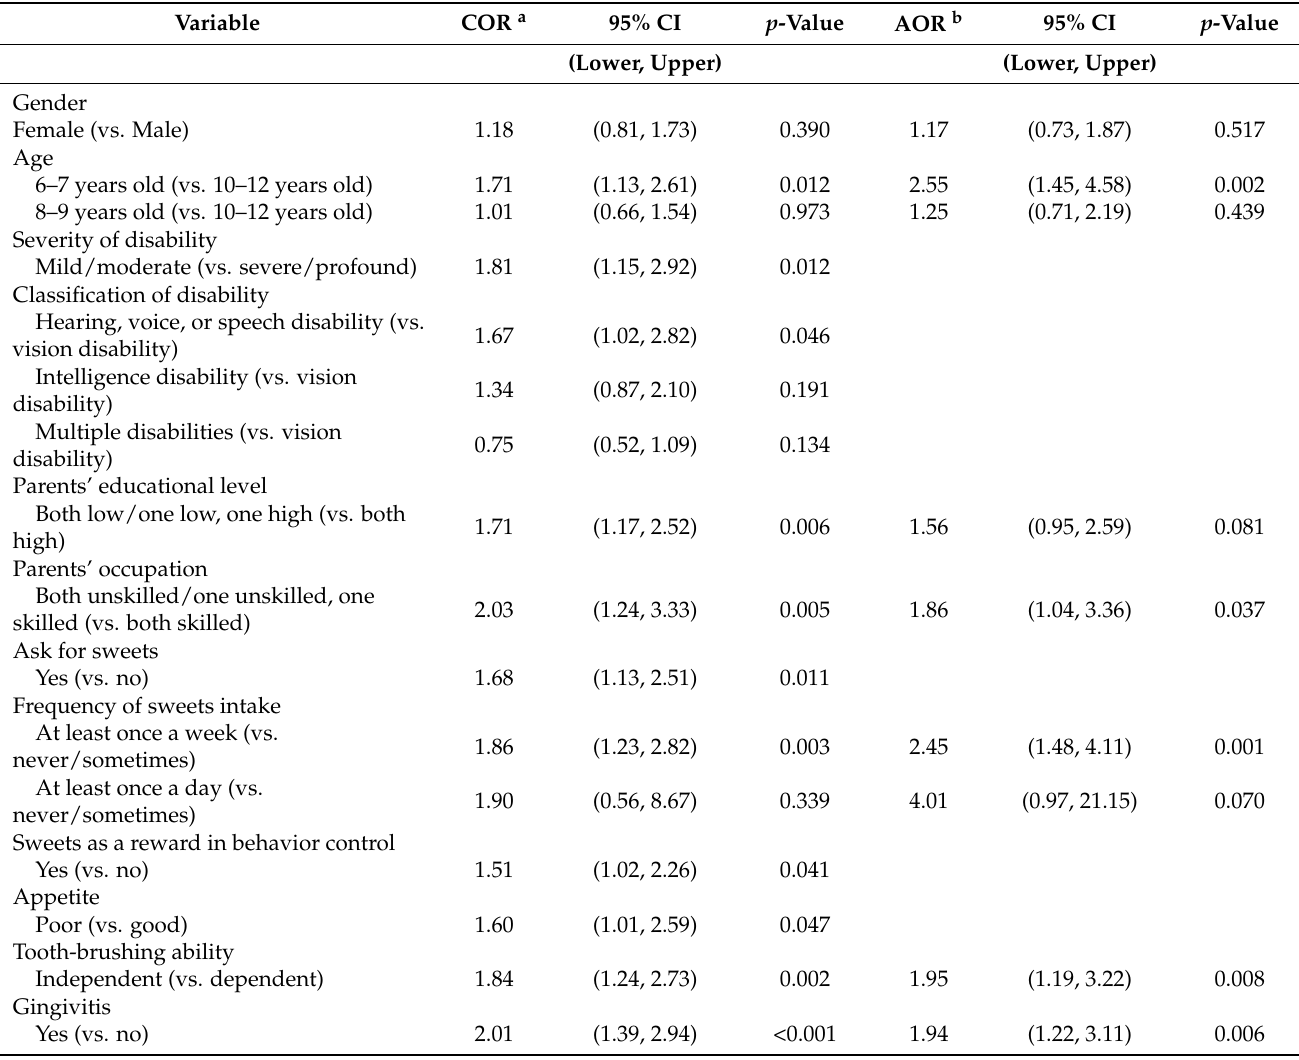
Table 4. Logistic regression models of risk factors associated with restorative treatment needs among children with